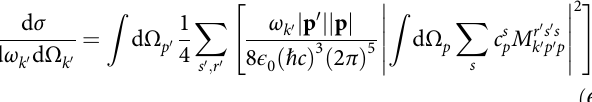
the two states have probability 0.5, a π phase shift with respect to each other, and propagate at ±15 o with respect to the + z